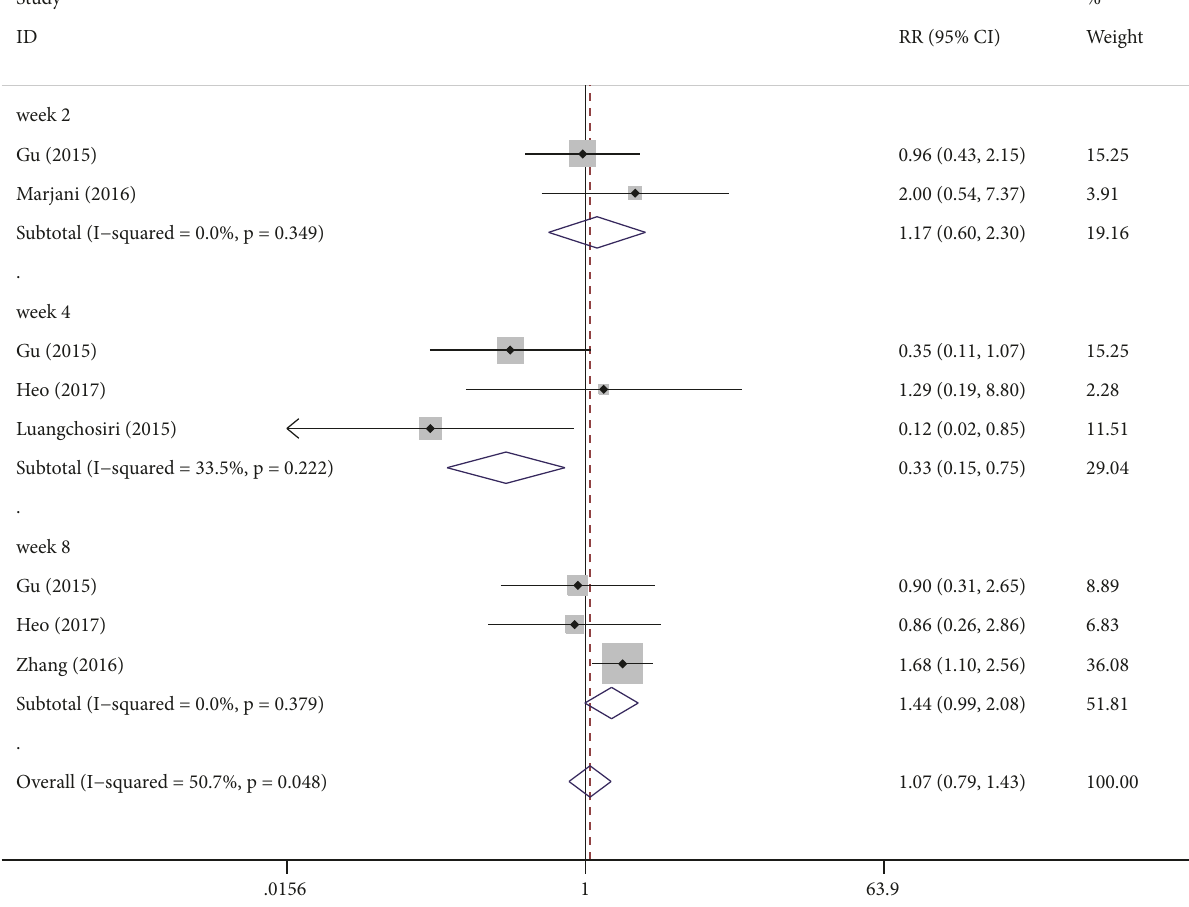
Figure 2: Effect of silymarin on the occurrence of anti-TB DILI with regard to time of follow-up.